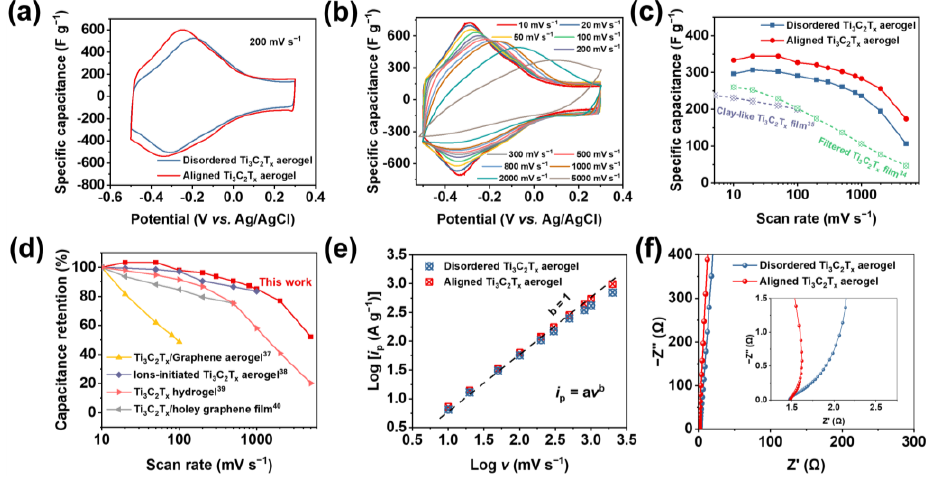
Figure 2. ( a ) CV curves of disordered and aligned Ti 3 C 2 T x aerogel at 200 mV s −1 . ( b ) CV curves from 10 to 5000 mV s −1 for aligned Ti 3 C 2 T x aerogel. ( c ) Specific capacitance versus scan rate for disordered and aligned Ti 3 C 2 T x aerogel in comparison with previously reported Ti 3 C 2 T x film. ( d ) Rate capabilities of aligned Ti 3 C 2 T x aerogel compared with Ti 3 C 2 T x -based electrodes in recently reported works. (The capacitance retention is estimated and calculated from the plots in the literature by the graph digitizer software Getdata.) ( e ) The plot of peak current response against scan rates. ( f ) Nyquist plots.